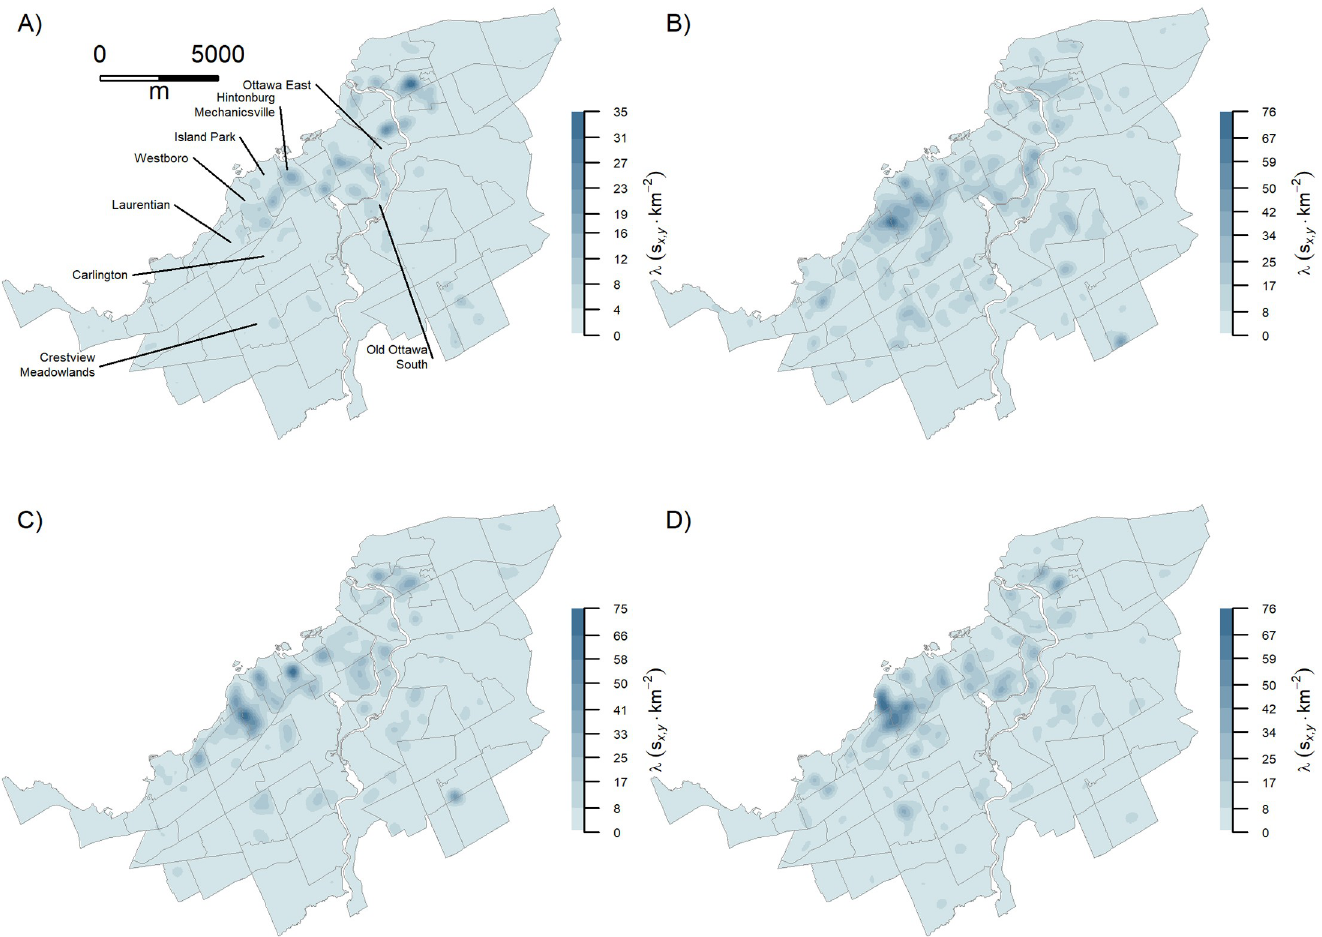
Fig 6. SCNN-FC-8 detections over time. A) 2007–2009—with select neighborhoods labelled; B) 2009–2012; (c) 2012–2014; (d)